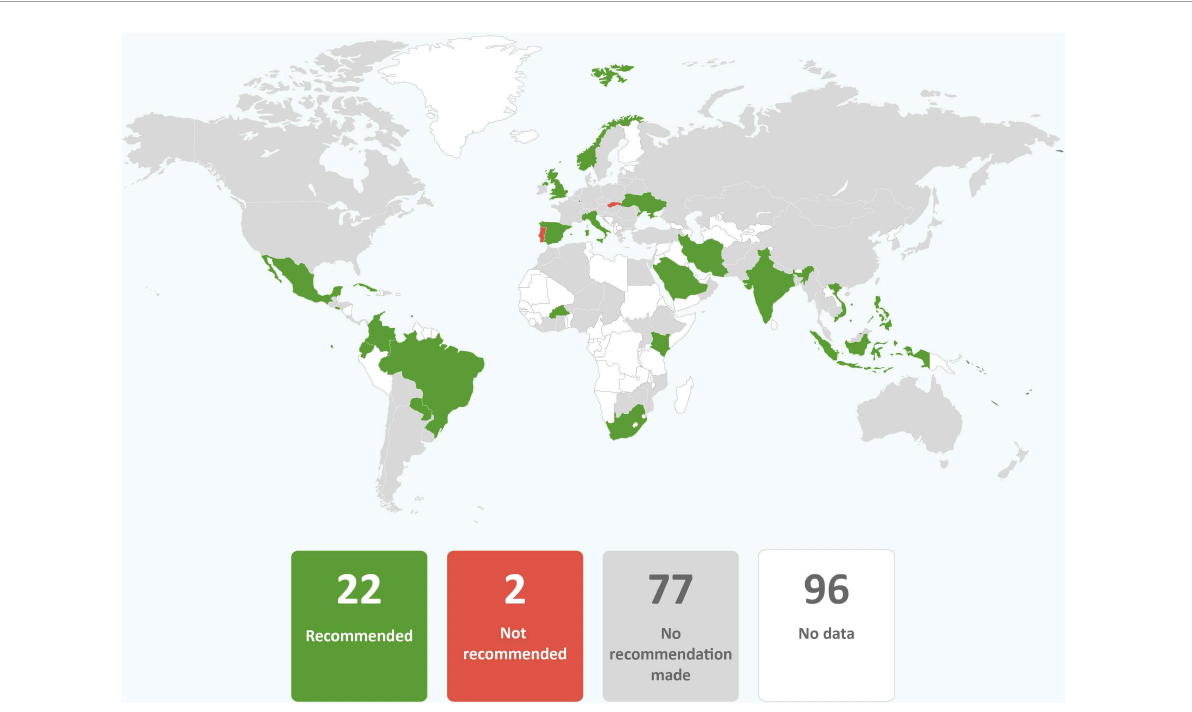
FIGURE10 Global distribution of recommendations on providing donor human milk to infants of mothers with COVID-19 unable to provide their own breastmilk (data from 101 countries).